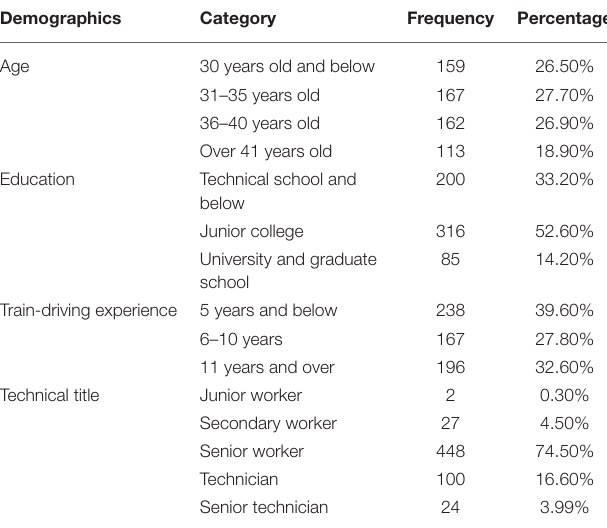
TABLE 1 | Demographic characteristics of respondents ( N =